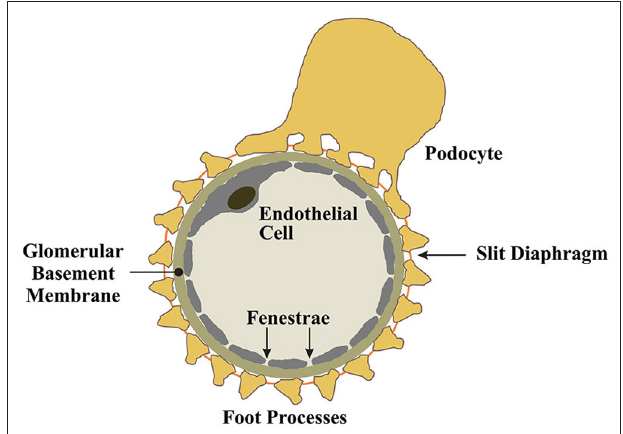
FIGURE 1 | Mechanisms of proteinuria in